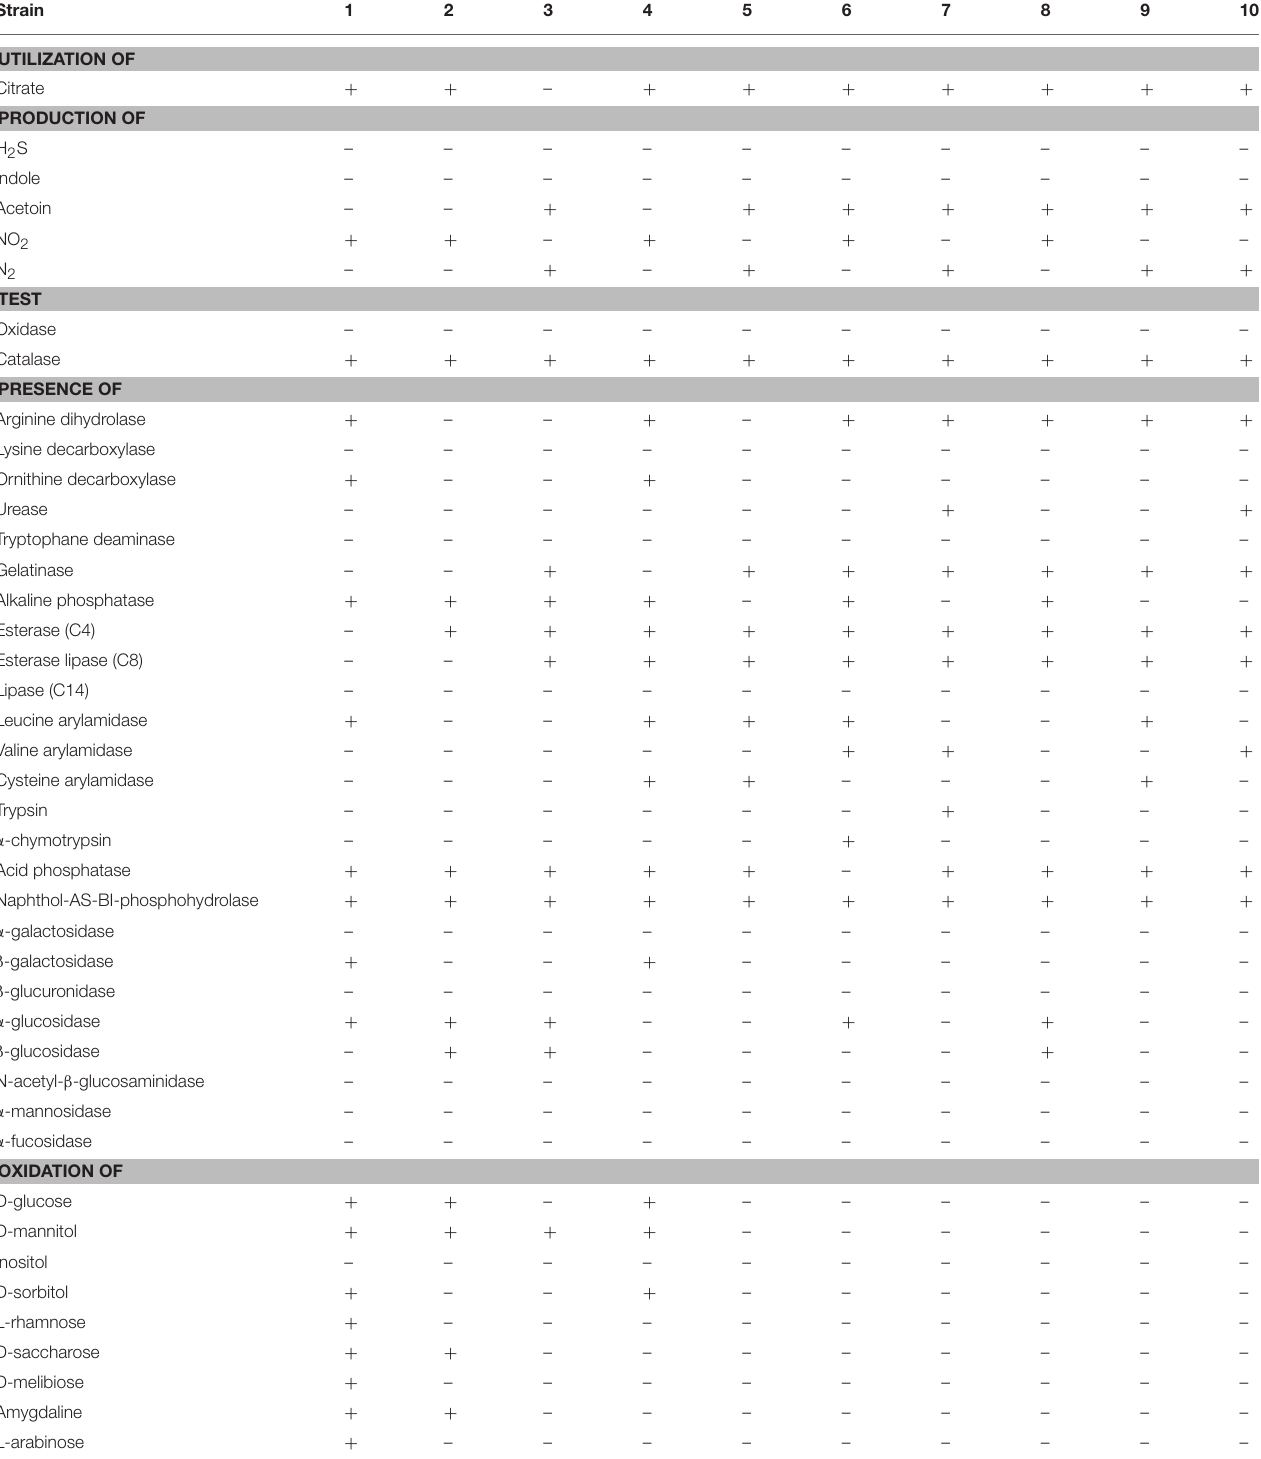
TABLE 1 | Physiological characterization of metal(loid)-resistant